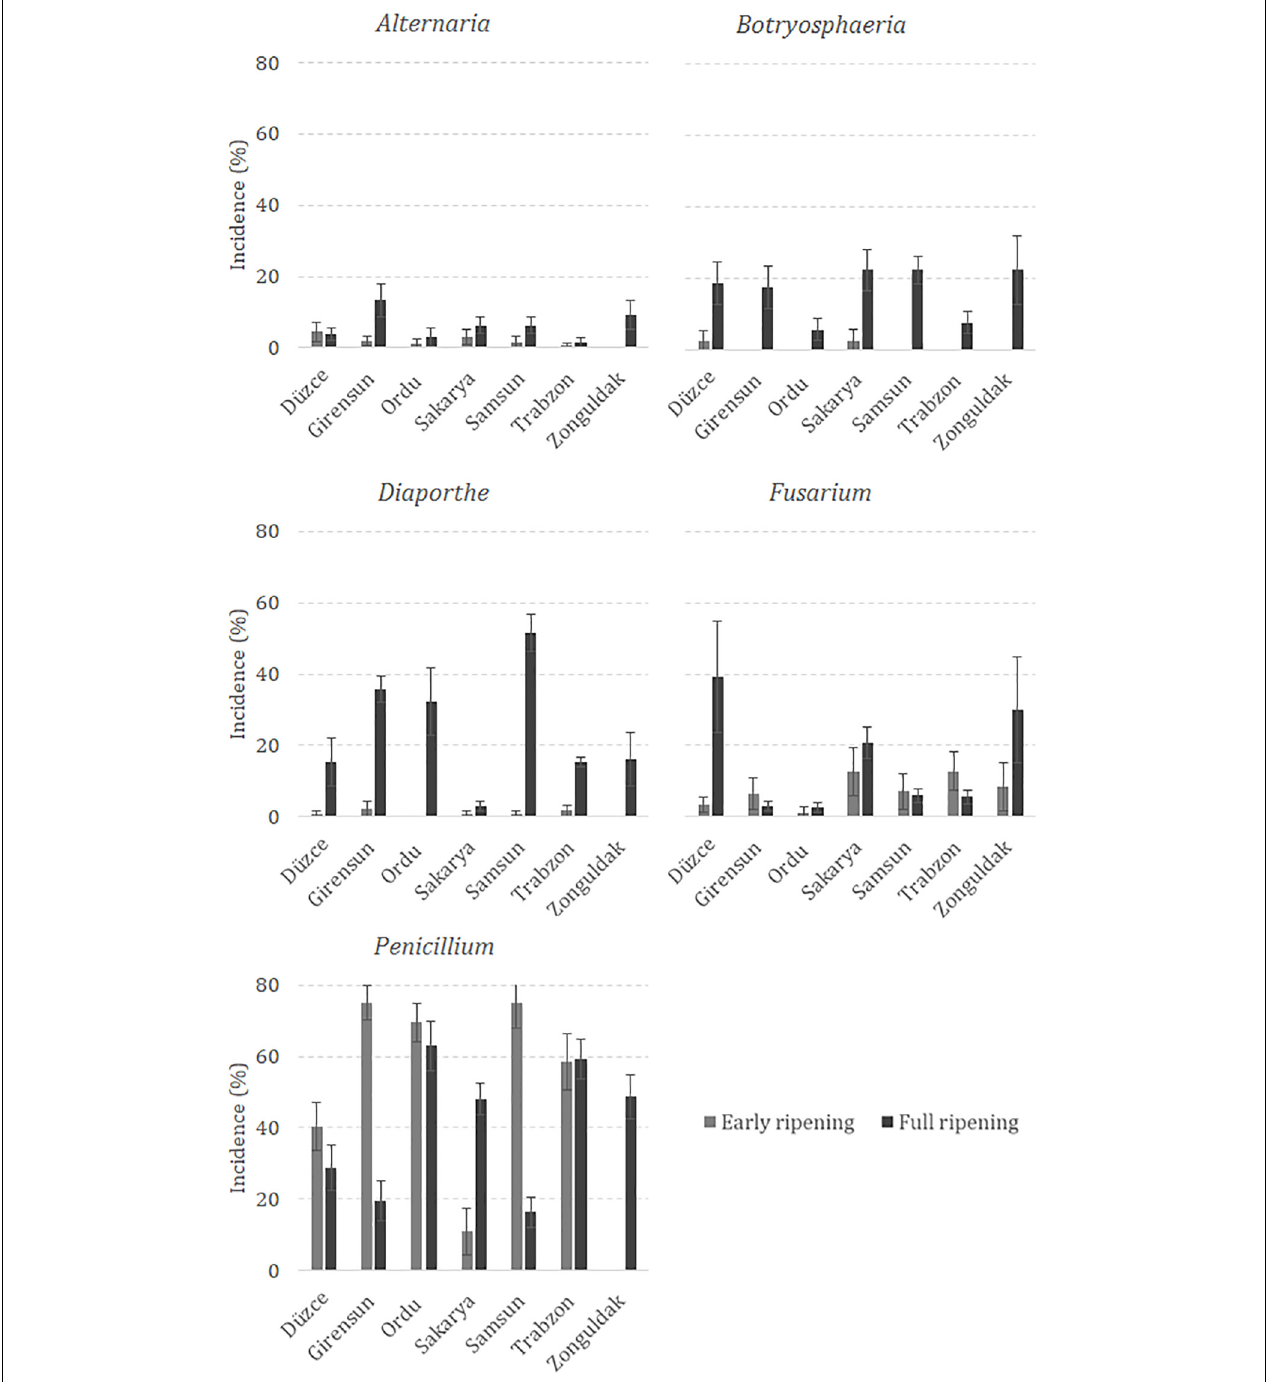
FIGURE 2 | Mean incidence of Alternaria, Botryosphaeria, Diaporthe, Fusarium and Penicillium isolated from hazelnuts sampled in Düzce, Giresun, Ordu, Sakarya, Samsun, Trabzon and Zonguldak at early and full ripening.